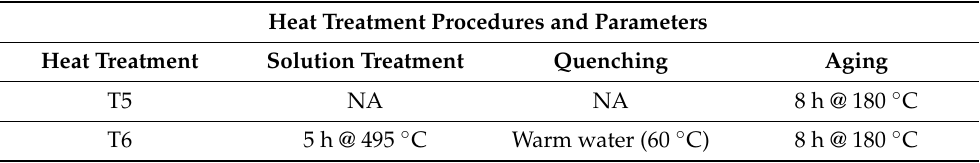
Table 2. Heat treatment procedures and parameters applied to the alloys